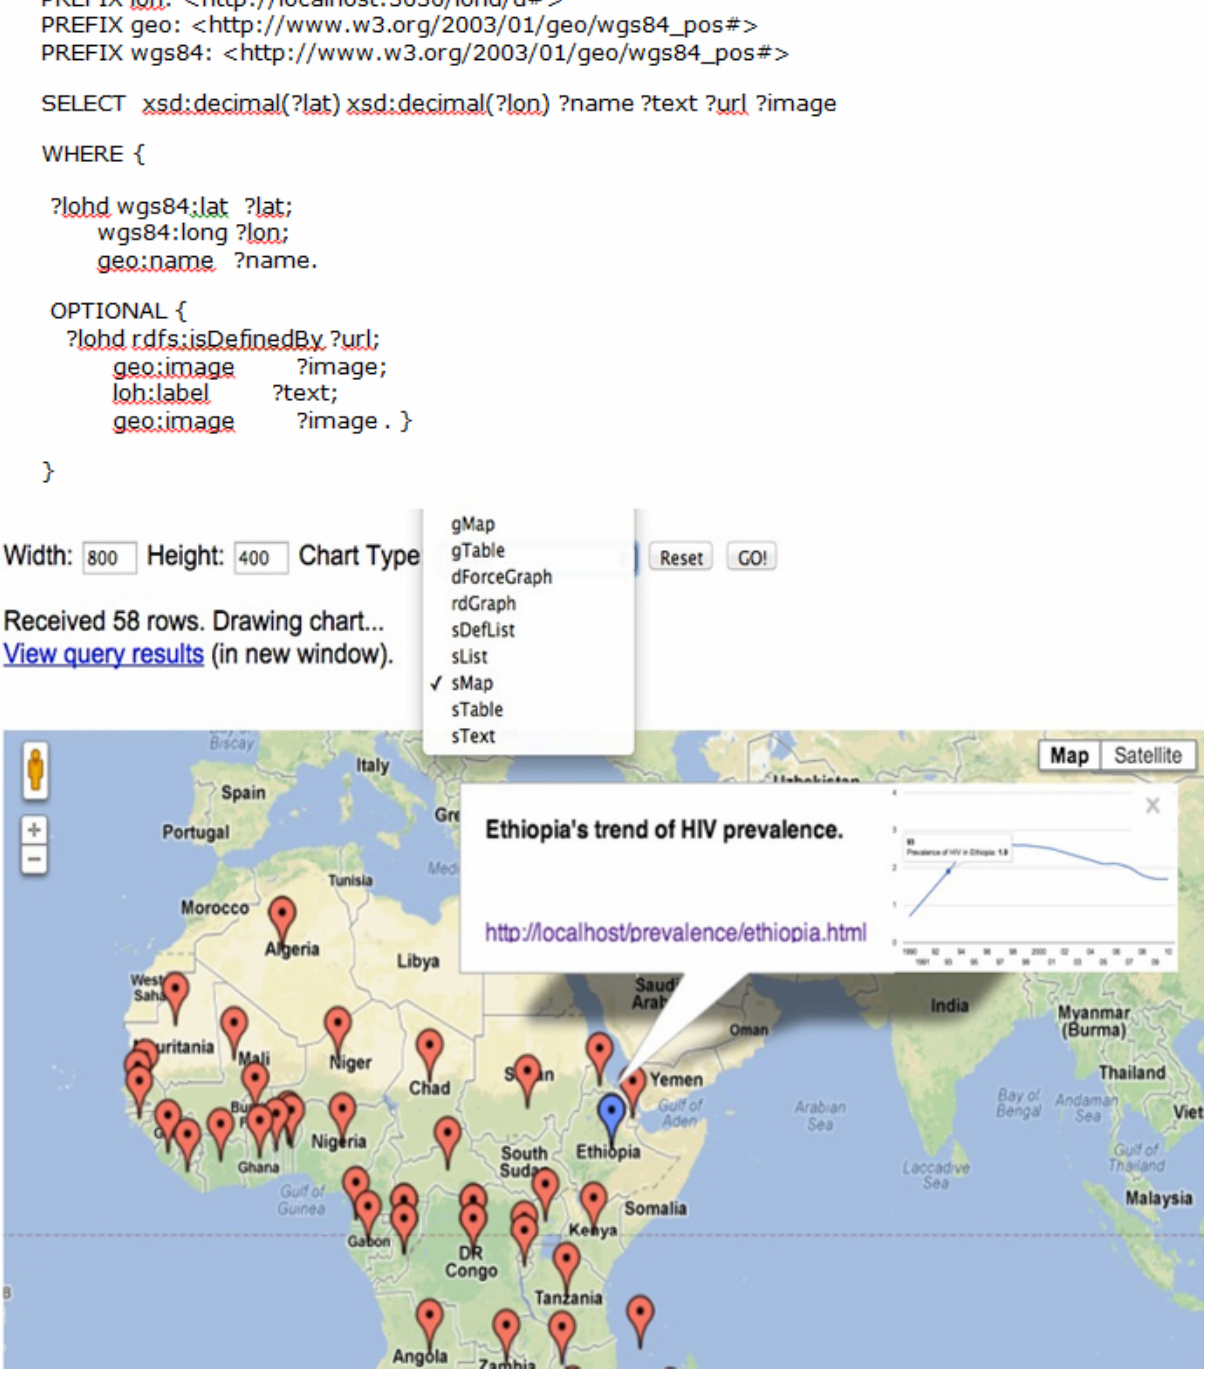
Figure 4. Location-based visualization of HIV prevalence in sub-Saharan Africa. The health-related data and the time series graph are displayed by clicking on the map of the